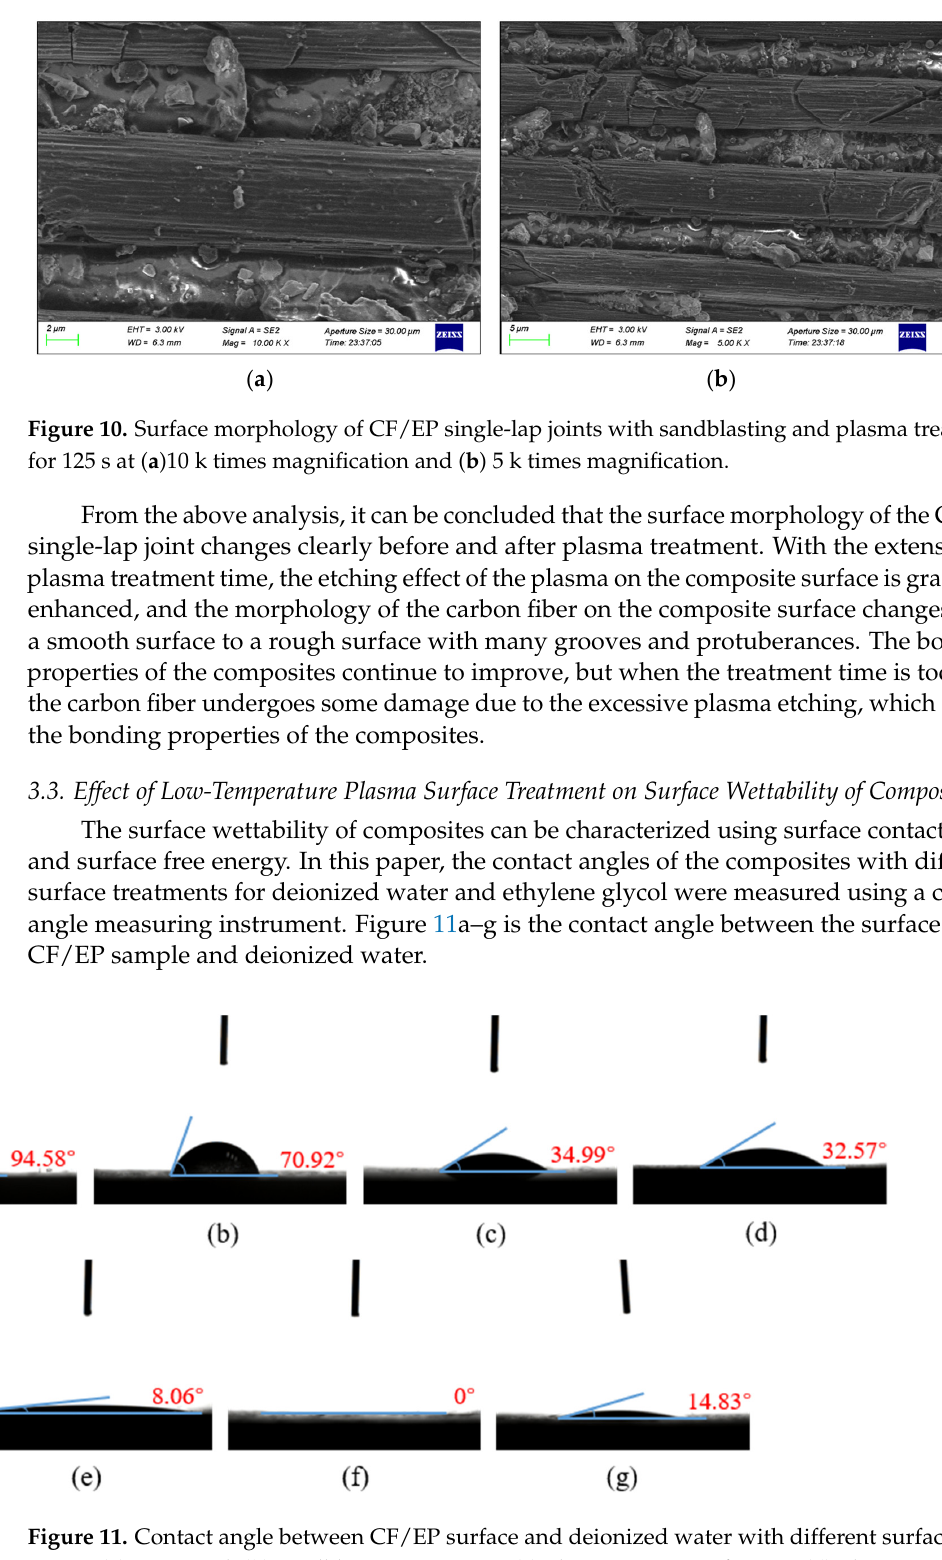
Figure 11. Contact angle between CF/EP surface and deionized water with different surface treat- ments. ( a ) Untreated, ( b ) sandblasting treatment, ( c ) plasma treatment for 60 s, ( d ) plasma treatment for 120 s, ( e ) plasma treatment for 300 s, ( f ) plasma treatment for 600 s and ( g ) sandblasting and plasma treatment for 120 s.